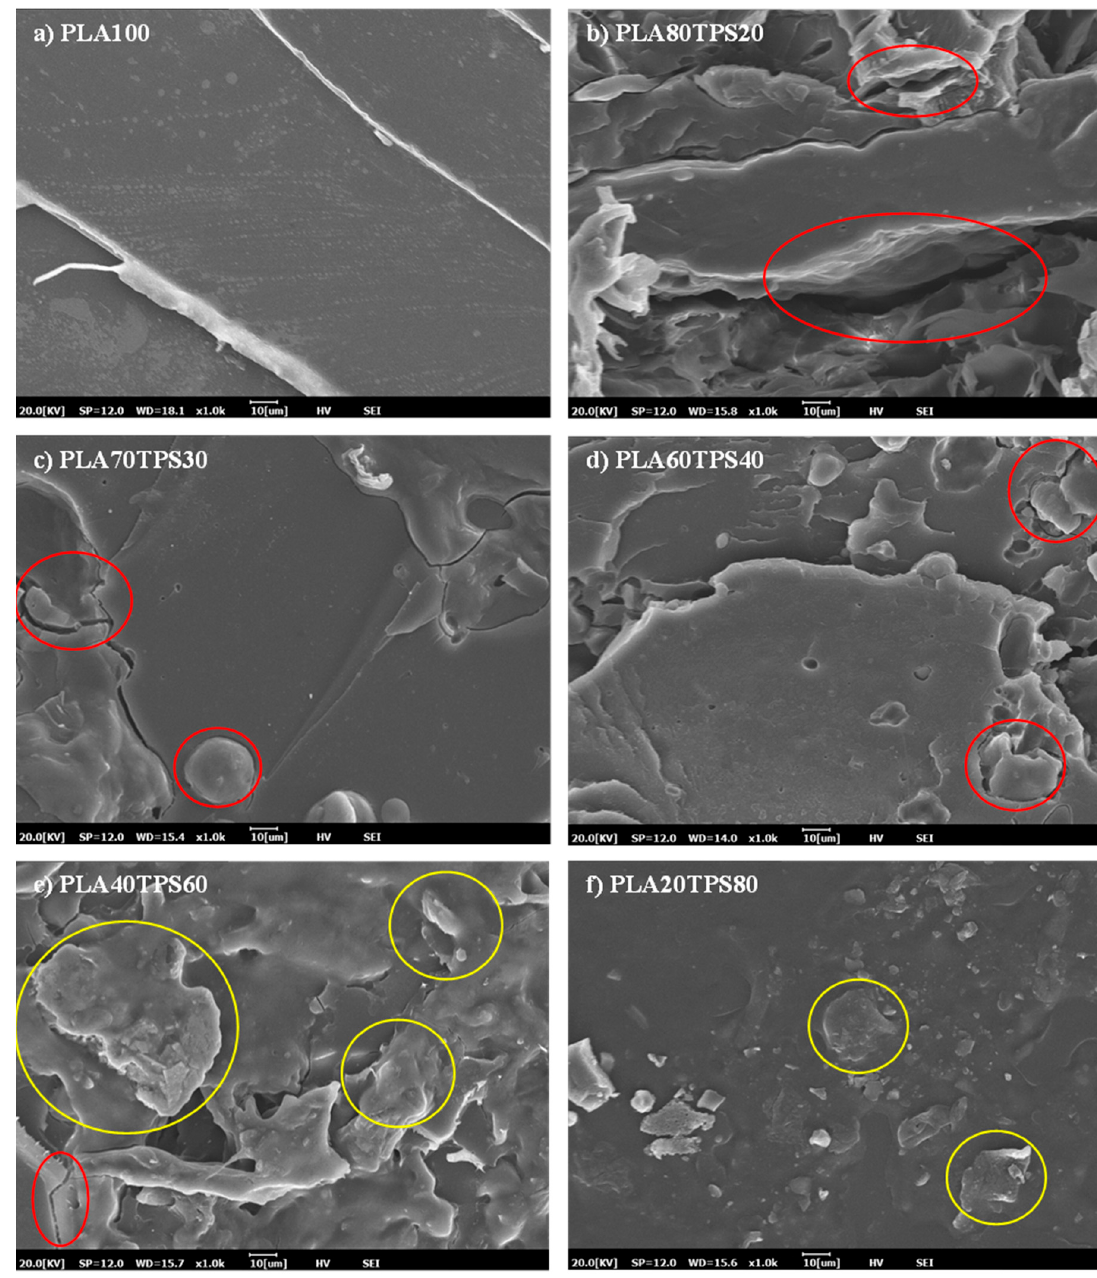
Figure 3. SEM images of tensile fractured surfaces for ( a ) PLA100, ( b ) PLA80TPS20, ( c ) PLA70TPS30, ( d ) PLA60TPS40, ( e ) PLA40TPS60, ( f ) PLA20TPS80.